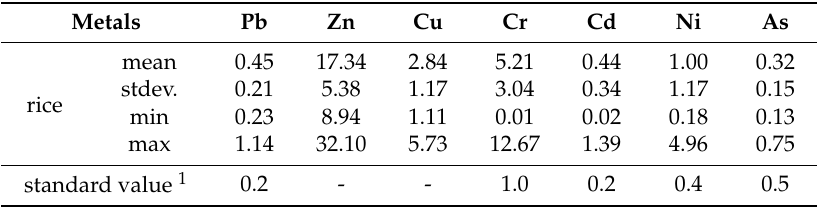
Table 5. Metal concentrations in edible parts of rice (mg/kg).